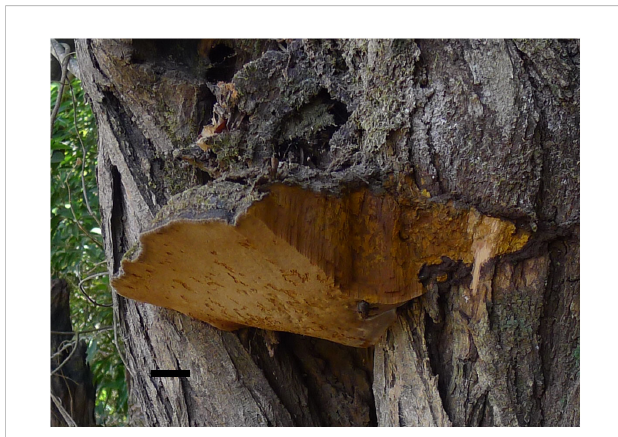
FIGURE 3 A basidiomata of Fulvifomes acaciae (holotype, JV 2203/71-J). Scale bar: 1